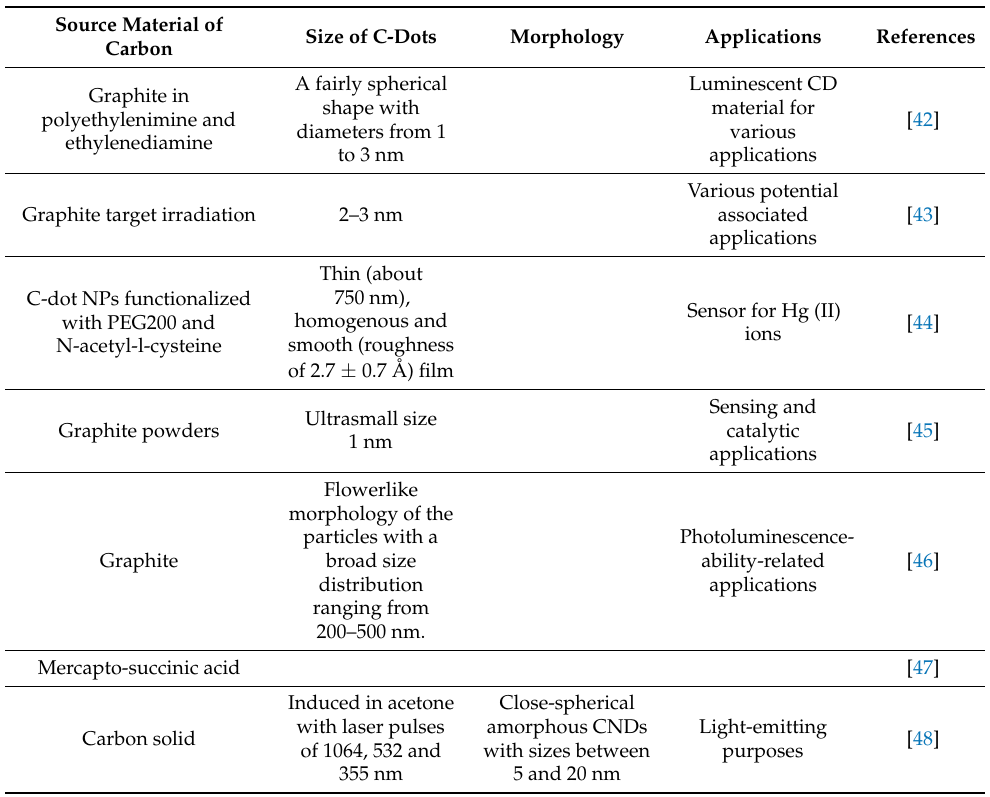
Table 1. Laser-ablation-based synthesis of carbon